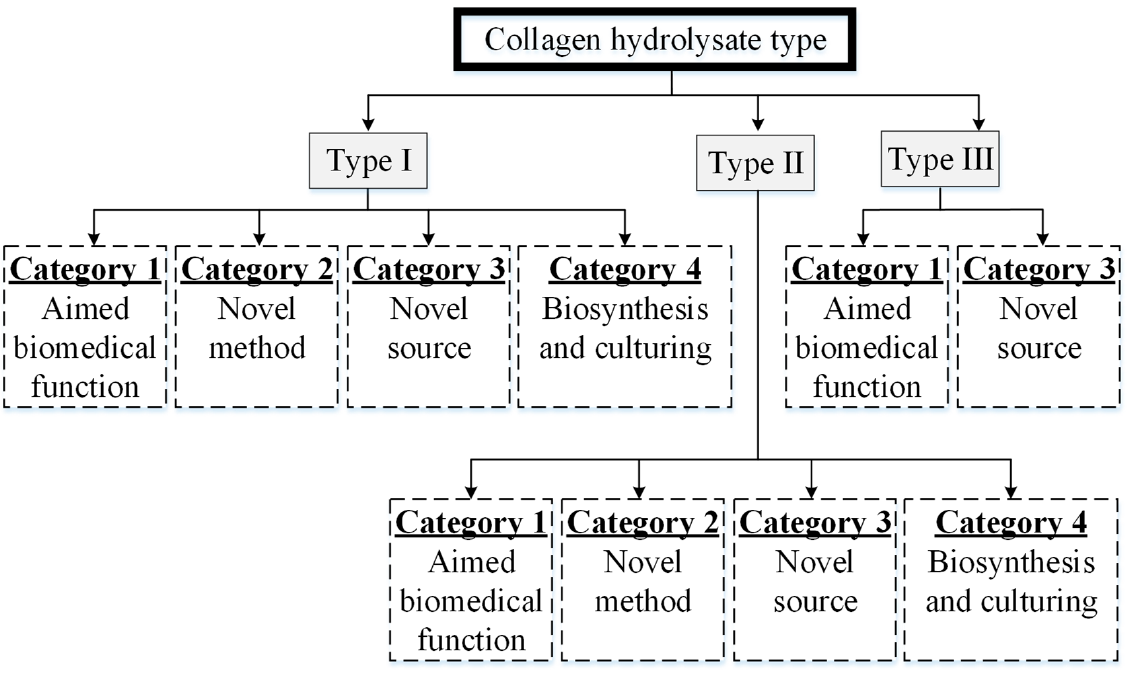
Figure 2. Hierarchical segregation with respect to the “Type” of collagen or collagen hydrolysate or gelatin.